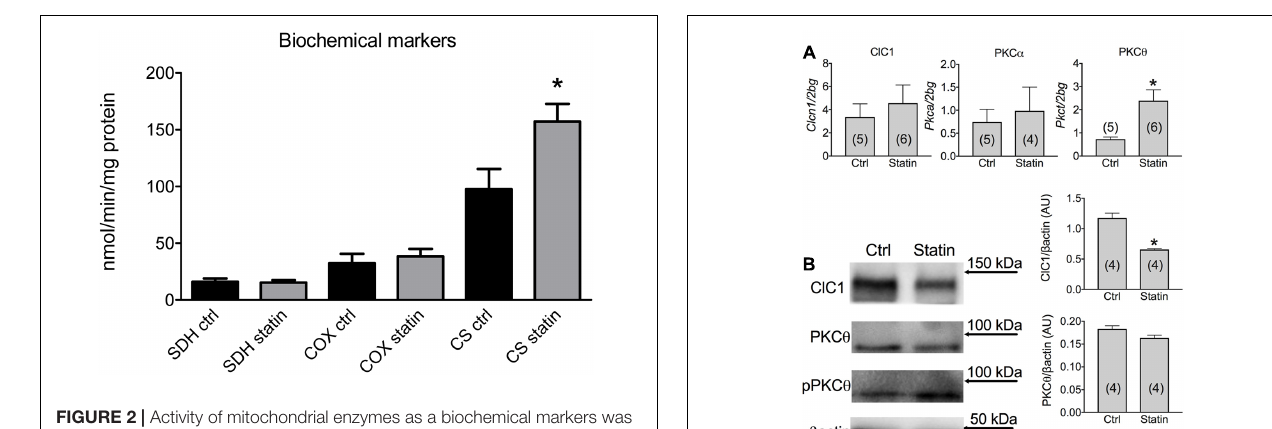
FIGURE 2 | Activity of mitochondrial enzymes as a biochemical markers was measured in muscle biopsies of statin-treated myopathic (statin) and untreated (ctrl) subjects. Bars represent the mean value ± SEM of succinate dehydrogenase (SDH), cytochrome oxidase (COX) and citrate synthetase (CS) activity measured in 10 statin-treated subjects and 9 untreated subjects. ∗ Significantly different with respect to control value ( p < 0.05) by Student’s t -test.